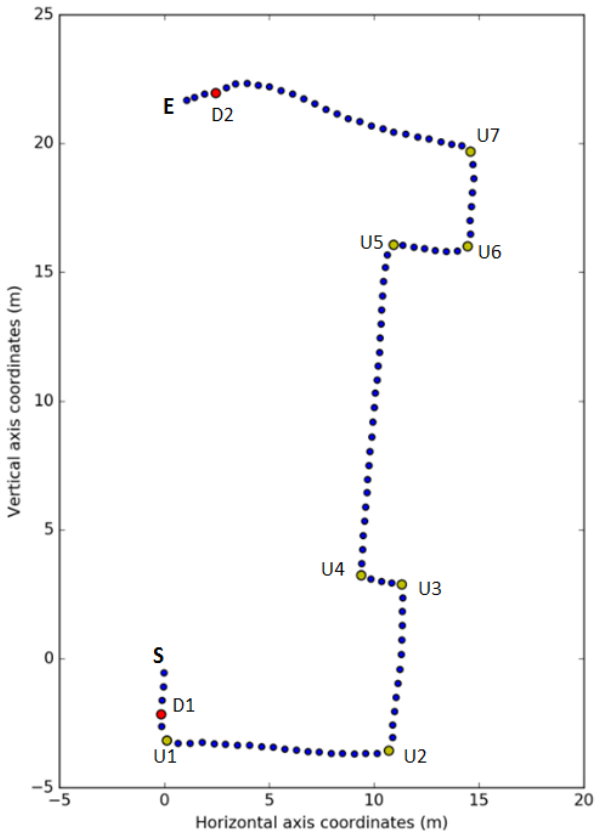
Figure 7. Trajectory segmentation. S and E represent the start and end points, respectively. The red dots indicate the detected door nodes, and the yellow dots represent the detected turn nodes.